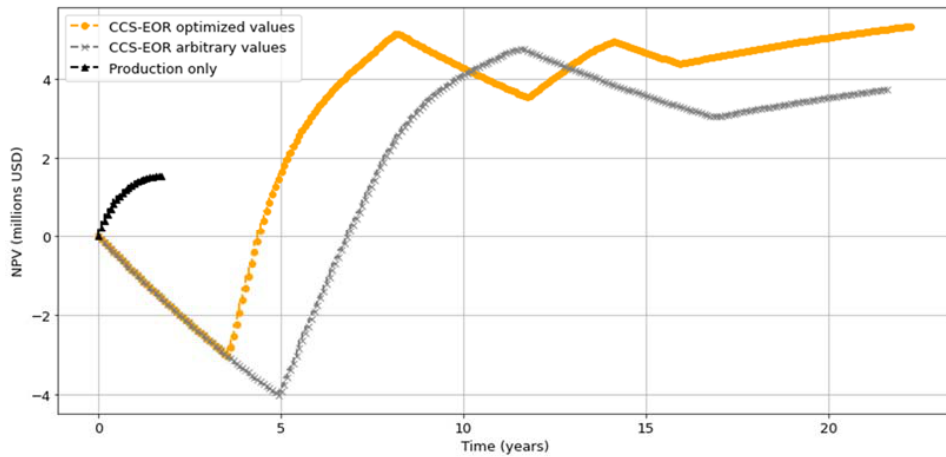
Figure 9. Comparison of NPV. Table 2. Comparison of present values.